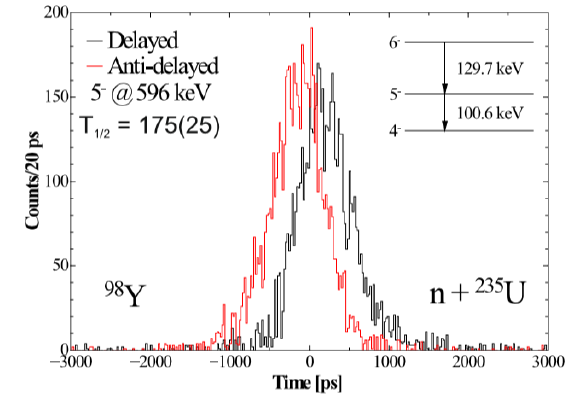
Fig. 1. TAC spectra of the corresponding distributions D stop (black) and D start (red) are